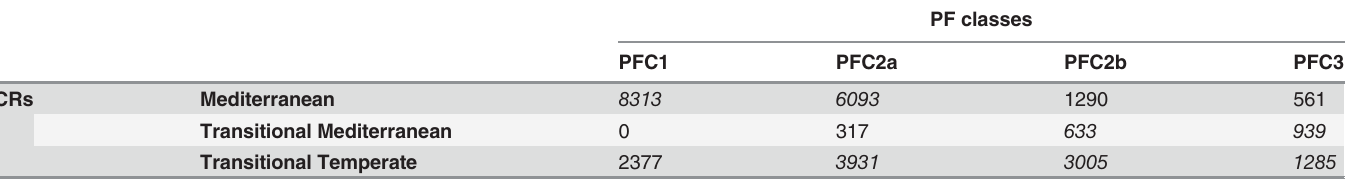
Table 3. Contingency table showing the number of fi res shared by the phenological fuel classes (PFCs) and the Climatic Regions (CRs) of Sardinia during the period 2000 – 2010.